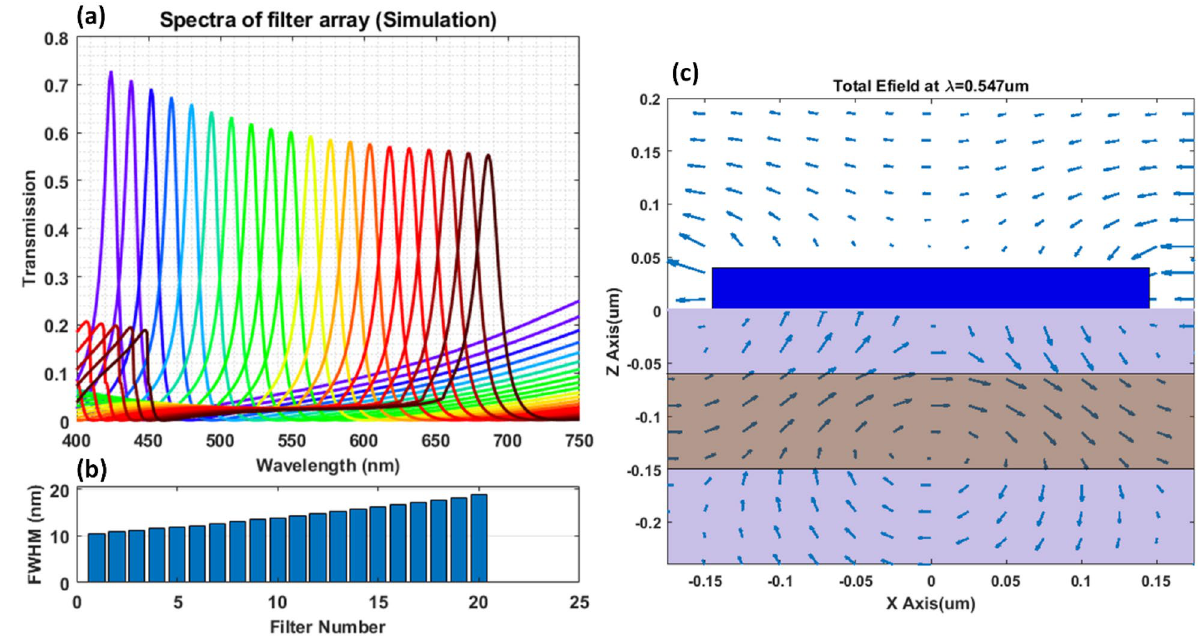
Figure 2. ( a ) Simulated spectra of filter array (20 filters) with period varied from 260 to 450 nm at 10 nm steps. ( b ) FWHM of each filter. ( c ) Total E-field plot of a unit cell of filter No. 10 at peak wavelength of 547